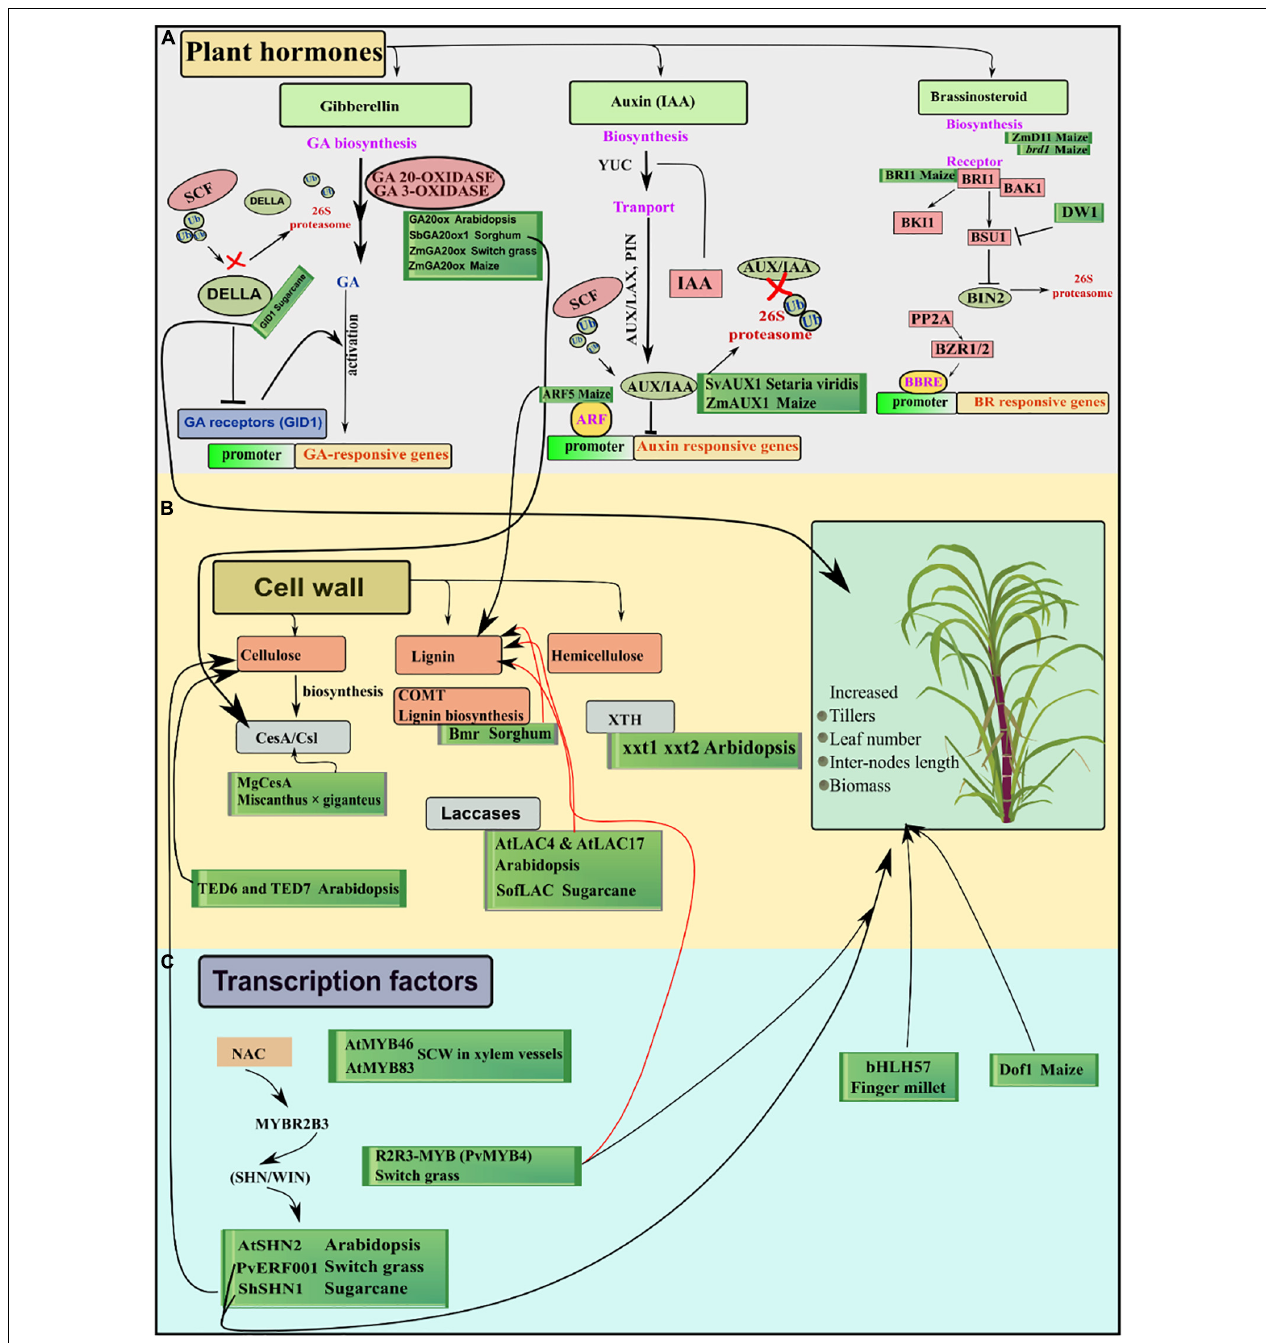
FIGURE 1 | Overview of the genes involved in different pathways in important C 4 biomass plants. (A) Highlights the hormone genes directly or indirectly related to growth and cell wall functioning. (B) Shows multiple genes involved in biosynthesis and remodeling of different cell wall-related components. (C) Transcription factors regulate many genes involved in different pathways of secondary cell wall synthesis leading to modified cell wall components improving saccharification efficiency. Black arrows show positive, red arrows show negative growth impacts and T lines show inhibitory influence on other genes. Whereas, green boxes enclose the functionally characterized genes in their respective